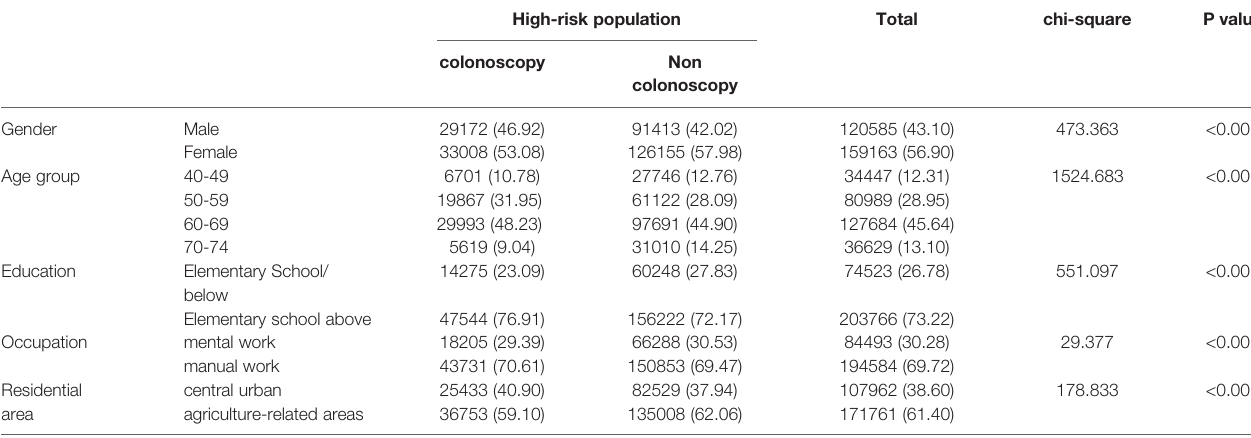
(33.14%) ( Table 8 and Figure 6C ), and higher in central urban areas (36.54%) than in agriculture-related areas (32.56%)